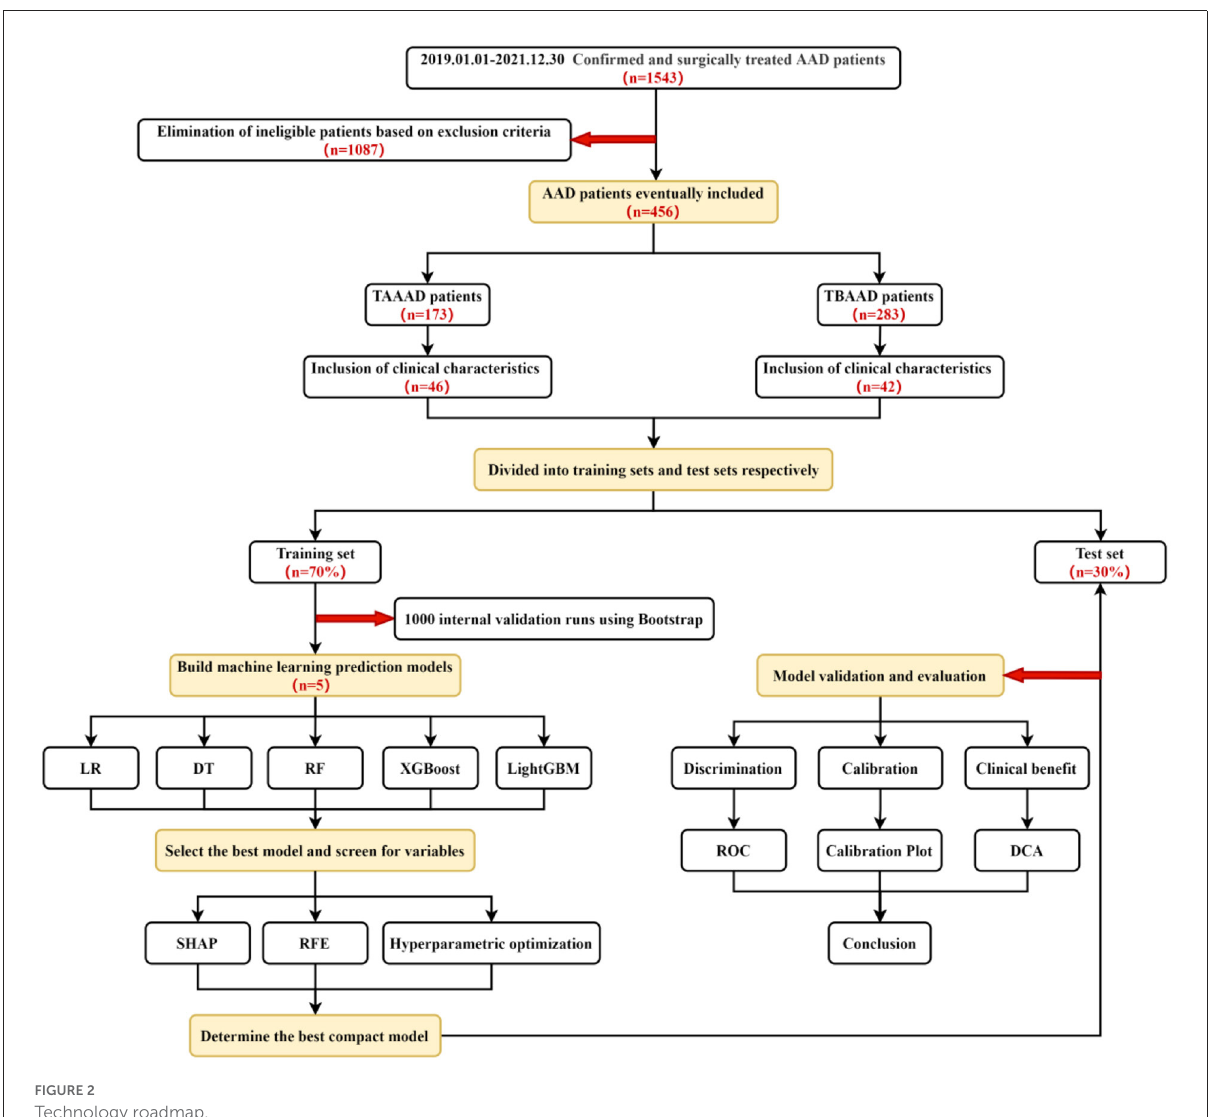
FIGURE2 Technology